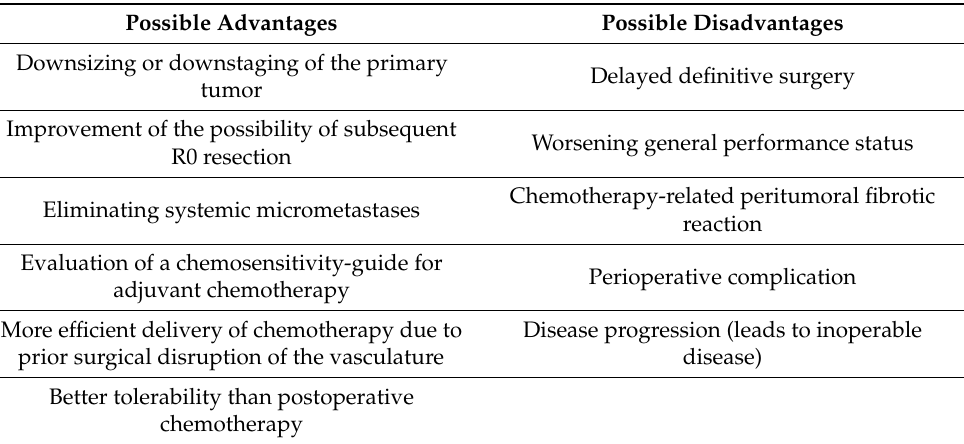
Table 1. List of potential benefits and risks of neoadjuvant chemotherapy. Possible Advantages Possible Disadvantages Downsizing or downstaging of the primary Delayed definitive surgery tumor Improvement of the possibility of subsequent Worsening general performance status R0 resection Chemotherapy-related peritumoral fibrotic Eliminating systemic micrometastases reaction Evaluation of a chemosensitivity-guide for adjuvant chemotherapy More efficient delivery of chemotherapy due to prior surgical disruption of the